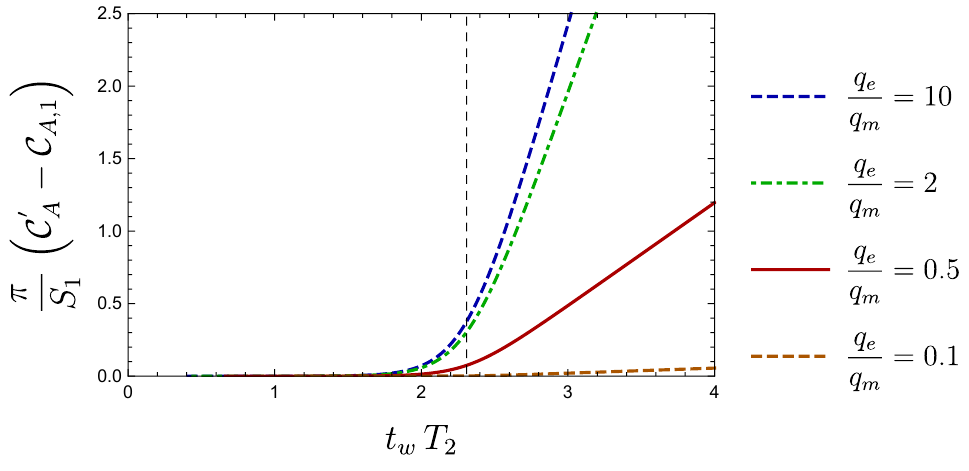
Figure 3 . The di(cid:11)erence of complexities of formation in the shock wave geometry as a function of the insertion time t w , for a light shock wave r + ; 2 = (1 + 10 (cid:0) 6 ) r + ; 1 and parameters L = 0 : 5 r + ; 2 , r (cid:0) ; 1 = 0 : 5 r + ; 2 and ‘ ct = L ( r (cid:0) ; 2 is then (cid:12)xed by the condition that q is the same after the shock T wave). The dashed vertical line is the scrambling time for the shock wave with these geometric parameters. We investigate the e(cid:11)ect of varying the ratio between electric and magnetic charges: after the scrambling time, the complexity essentially remains constant for the solution with mostly magnetic charges, as predicted by eq. (2.40).